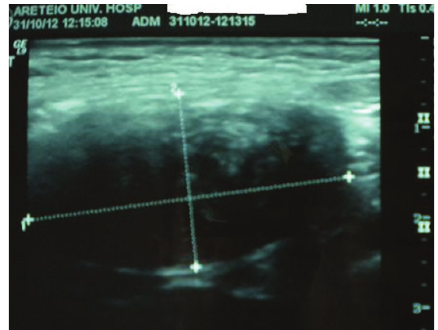
Figure 1: U/S image of the tumor.